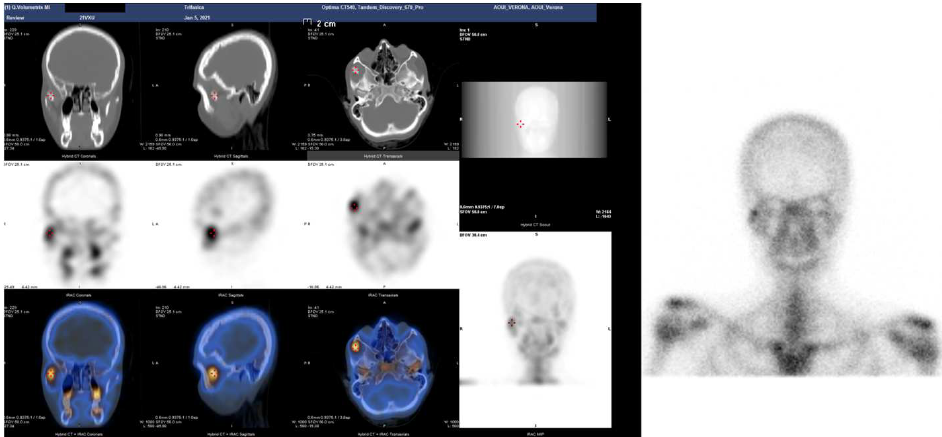
Figure 3. SPET-CT showing bone reworking in correspondence to the joint between the jaw and the right zygomatic bone compared to the contralateral homologous site.